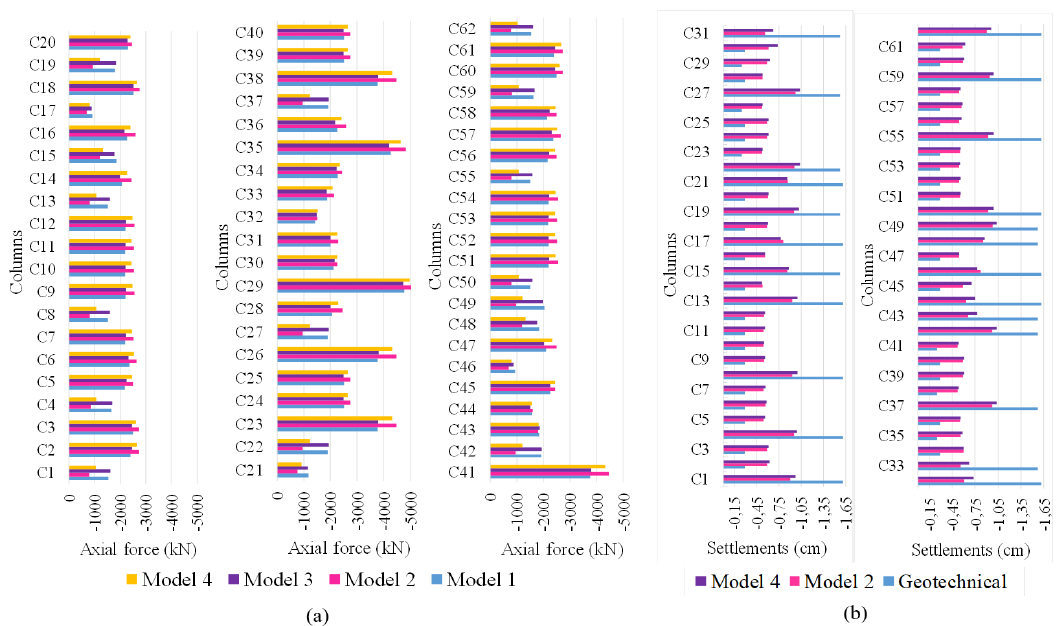
Figure 13. Columns and foundations results: (a) Maximum axial forces of the columns; (b) Foundation